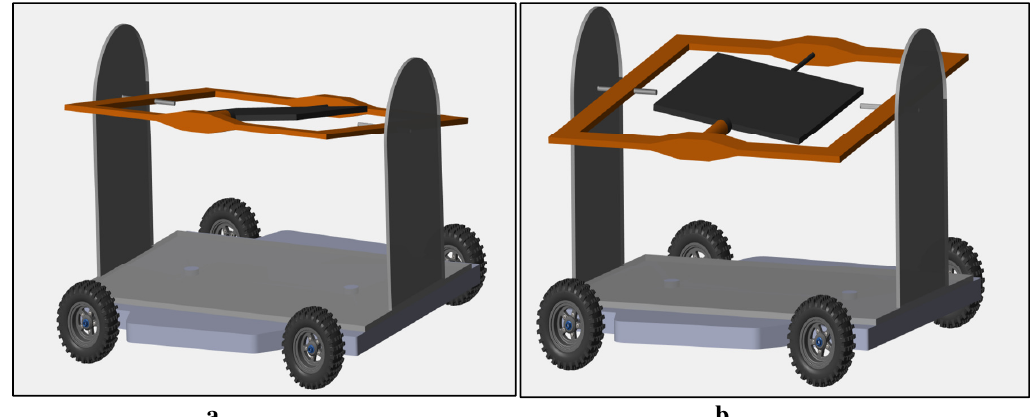
a b Fig. 15. Self-balancing of the (platform on the mobile car) structure in the virtual simulation a) under tilt angle (10° on positive X-axis and -10° on negative Y-axis) b) under tilt angle (-10° on negative X-axis and 10° on positive Y-axis). (tilt angle -10° on negative X-axis and -10° on negative Y-axis) shown in figure 16. The self- balancing of the (platform on the mobile car) structure in the virtual simulation environment under tilt angle (10° on positive X-axis and 10° on positive Y-axis) and tilt angle (-10° on negative X-axis and -10° on negative Y-axis) is shown in figure 17: (a,